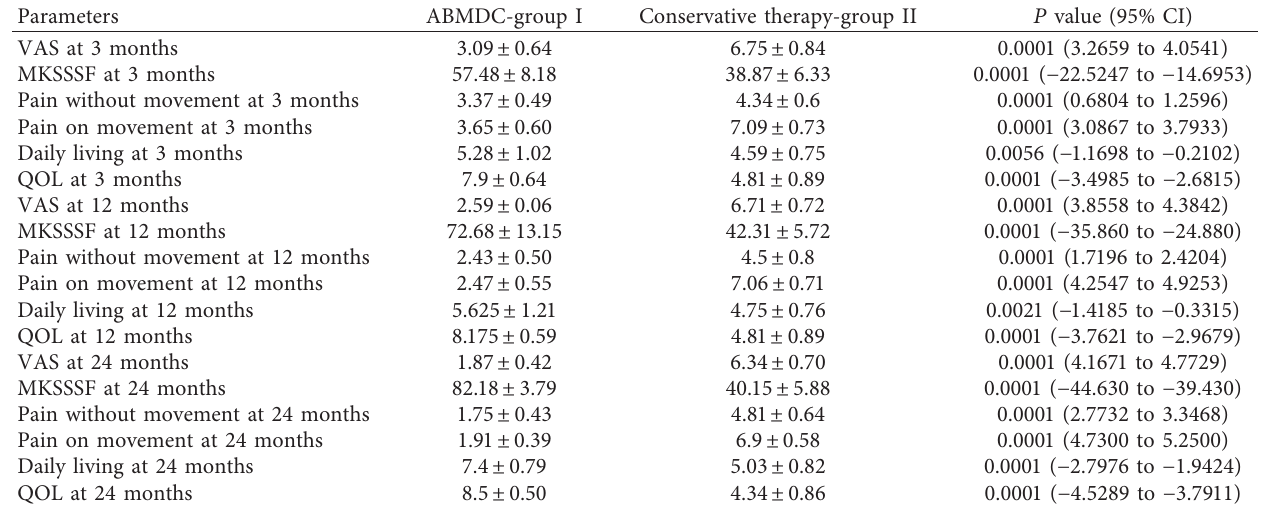
Table 2: Comparison between groups at 3, 12, and 24 months.